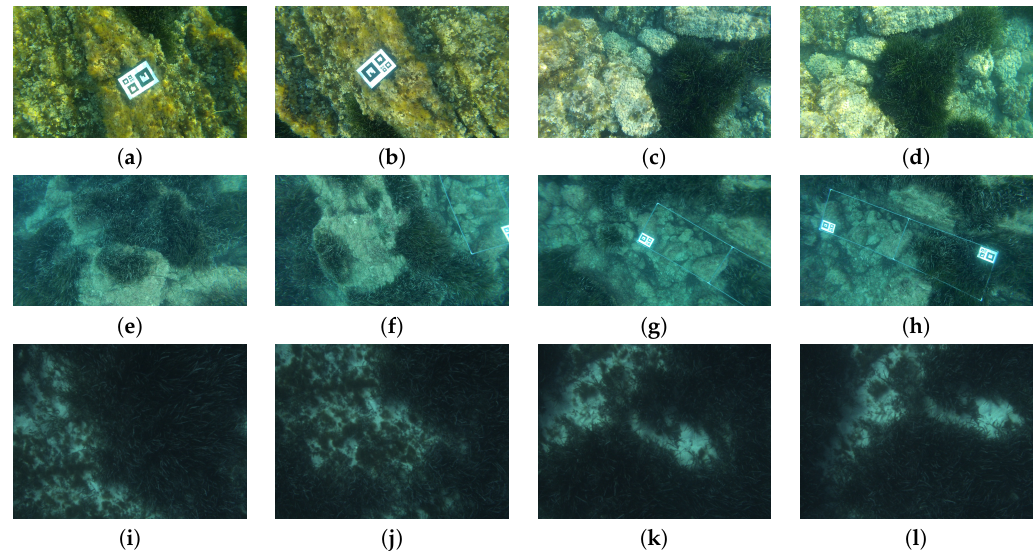
Figure 5. ( a – d ) Multi-session loops between sequences S 11 and S 12. ( e – h ) Multi-session loops between sequences S 21 and S 22. ( i – l ) Multi-session loops between sequences S 31 and S 32. ( a ) Closes a loop with ( b , c ) closes a loop with ( d , e ) close a loop with ( f , g ) close a loop with ( h , i ) closes a loop with ( j , k ) closes a loop with ( l